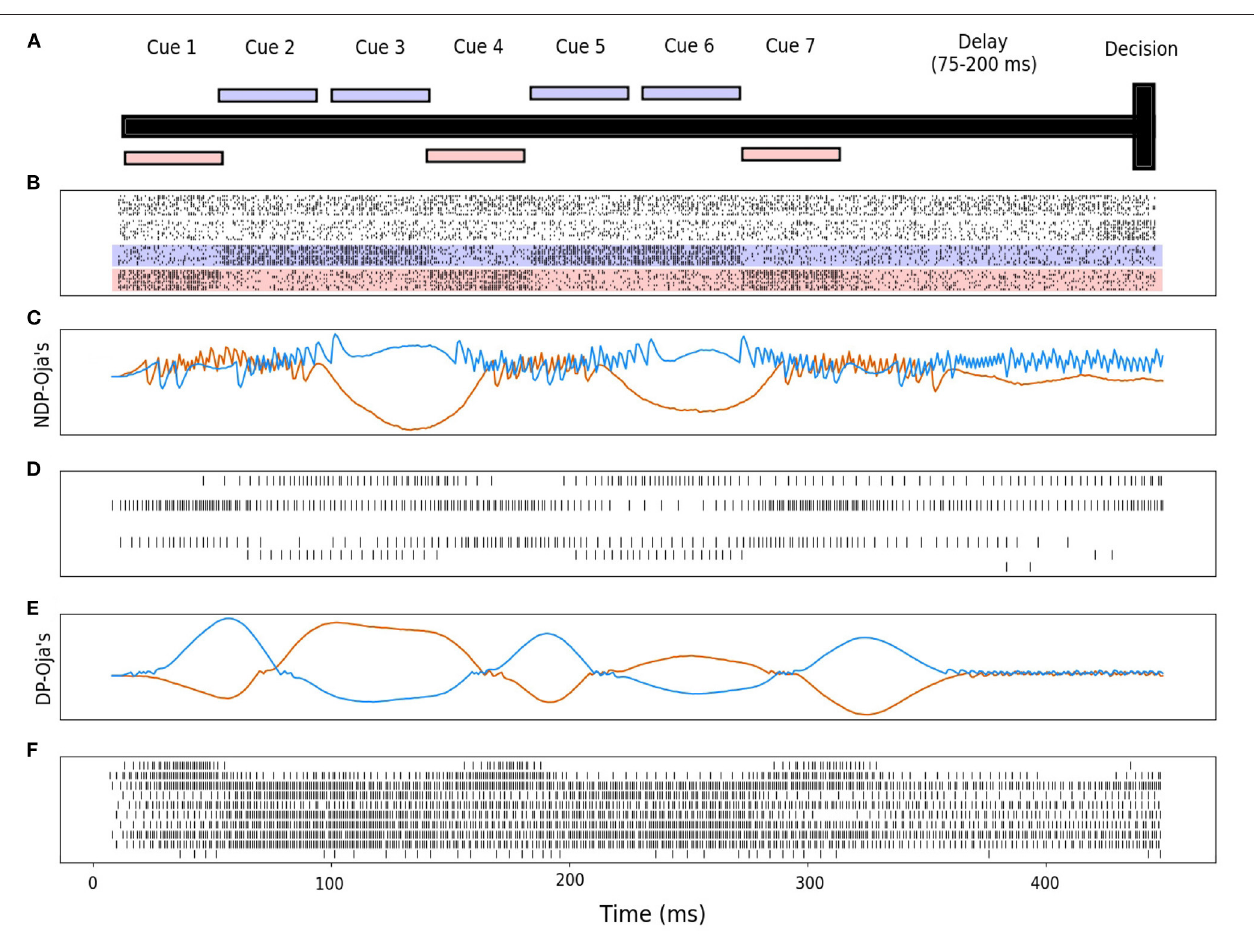
FIGURE 1 | (A) A graphical visualization of the cue-association T-Maze, where the cues are sequentially presented followed by a delay and decision period. The right cue is shown in red, the left in blue. (B) Displayed is the sensory neuron input activity. From bottom to top, the activity of ten neurons each represent left and right cues, followed by ten neurons for an action decision cue, and finally ten neurons that have activity with no relationship to the task. Membrane potential for the output neurons, and the spiking activity of a random subset of 10 hidden neurons for neuromodulated Oja’s rule (C,D) and non-modulated Oja’s rule (E,F) . The blue and red curves here correspond to the neuron representing the decision for choosing left or right, respectively, also corresponding to the left and right cue colors in (A,B) . In (D) , only 5 of the 10 neurons were actively spiking, whereas in (F) all 10